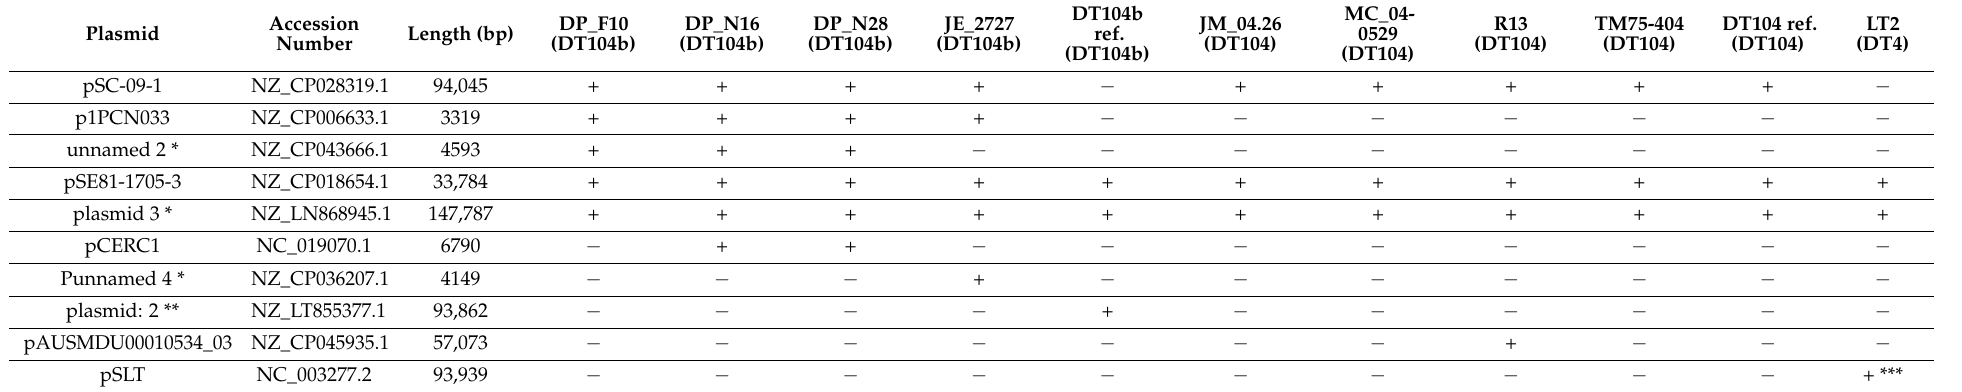
Table 7. Distribution of plasmids identified among the studied S. Typhimurium genomes using the PLSDB webserver [24].